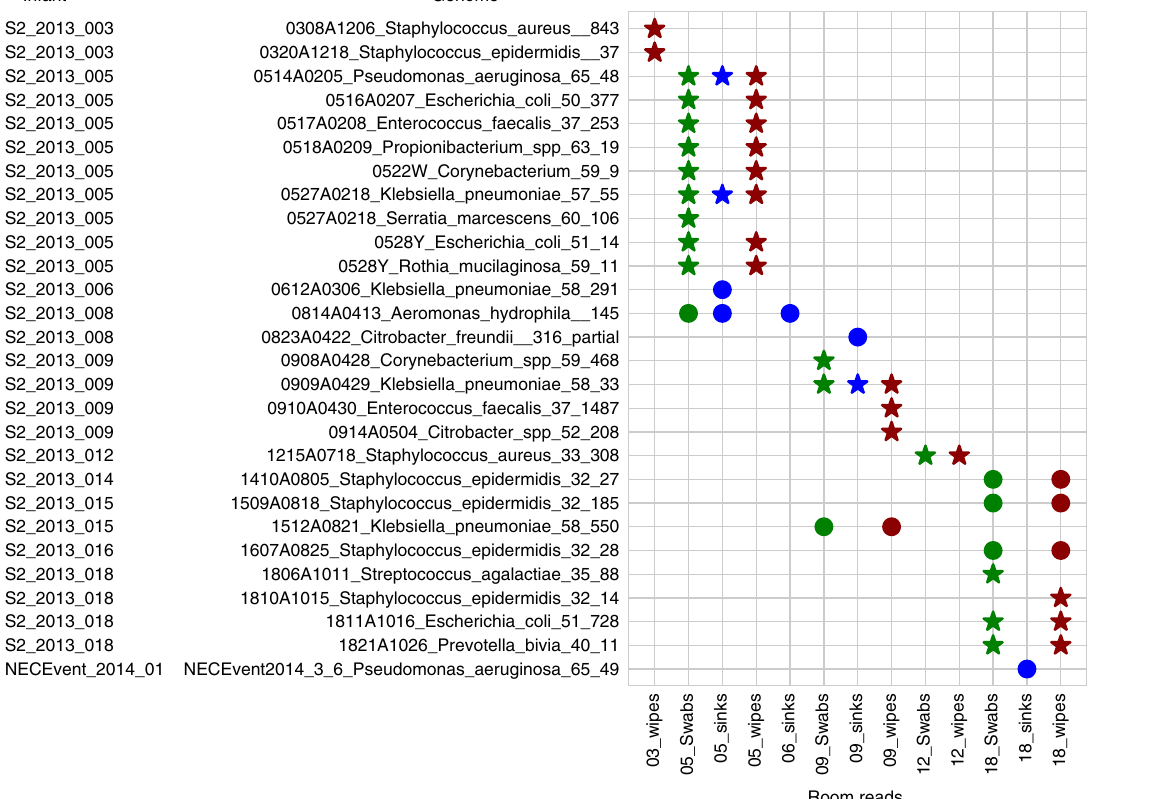
Fig. 2 Gut strains are consistently detected in the room. Room reads from all room samples were mapped to each infant ’ s dereplicated fecal genome set. Symbols indicate fecal genomes present in the room with at least 99.999% ANI. Circles represent cases where a fecal genome was detected in a separate room from which the infant was housed, and stars represent matched infant/room pairs. Wipe, swab, and sink metagenomes are fi lled in red, green, and blue,